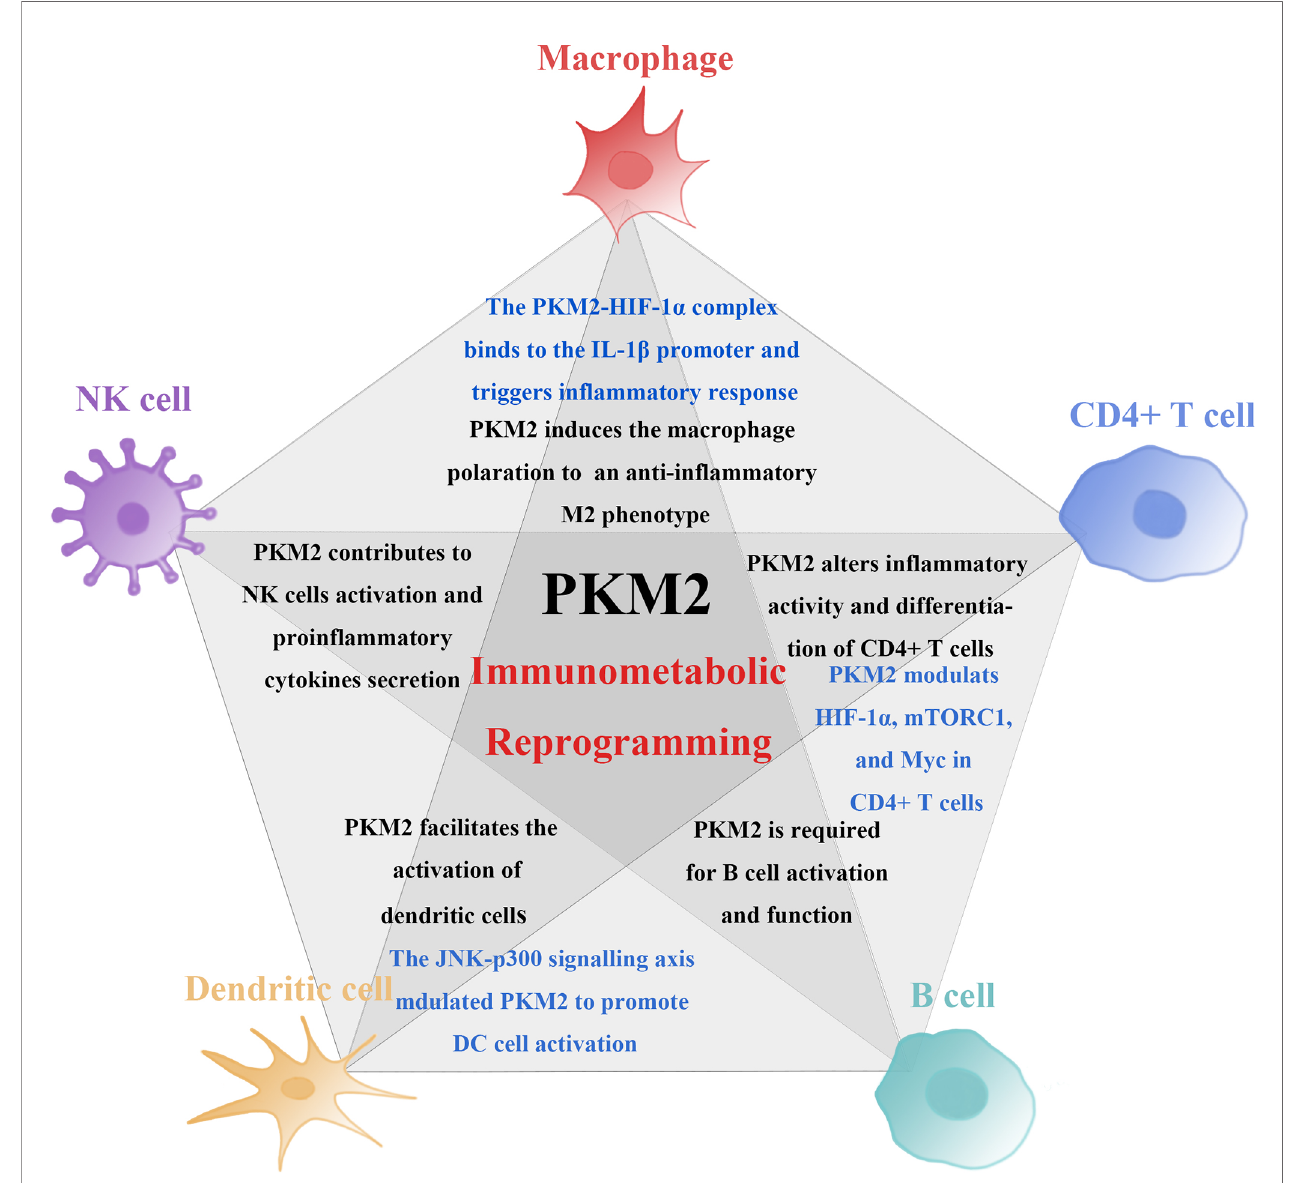
FIGURE 2 | PKM2 mechanisms involved in the induction of immune cell activity and proin fl ammatory function. PKM2 is involved in the induction of immune cell activity and proin fl ammatory function. PKM2 medicates changes in the proliferation and function of immune cells through metabolic and non-metabolic pathways. PKM2-mediated immunometabolic reprogramming promotes abnormalization of immune cells. Among these immune cells, the non-metabolic pathway induced by PKM2 is in different ways (marked in blue). Firstly, PKM2 triggers macrophages to polarise from a proin fl ammatory M1 phenotype to an anti-in fl ammatory M2 phenotype. The interaction of PKM2 and HIF-1 a forms a PKM2-HIF-1 a complex, binding to the IL-1 b promoter inducing the secretion of proin fl ammatory cytokines and triggers in fl ammatory response. Secondly, PKM2 controls the activation and effector functions of CD4+ T cell by modulating the functions of HIF-1 a , mTORC1, and Myc and engagement of aerobic glycolysis in TCR-activated CD4+ T cells. Lastly, PKM2 detetramerization and nuclear translocation induced by JNK-p300 signalling axis can promote DC cell